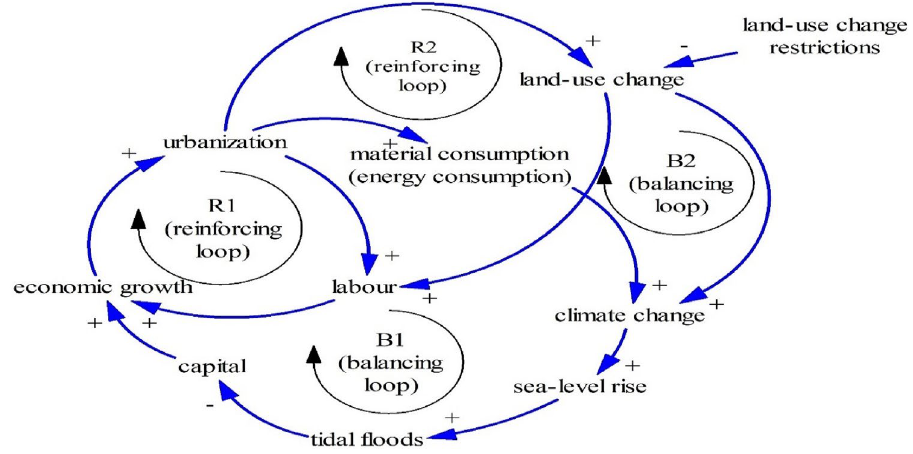
Figure 7. The Limits to Growth #1 (A notation of “#1” is used for numbering the Limits to